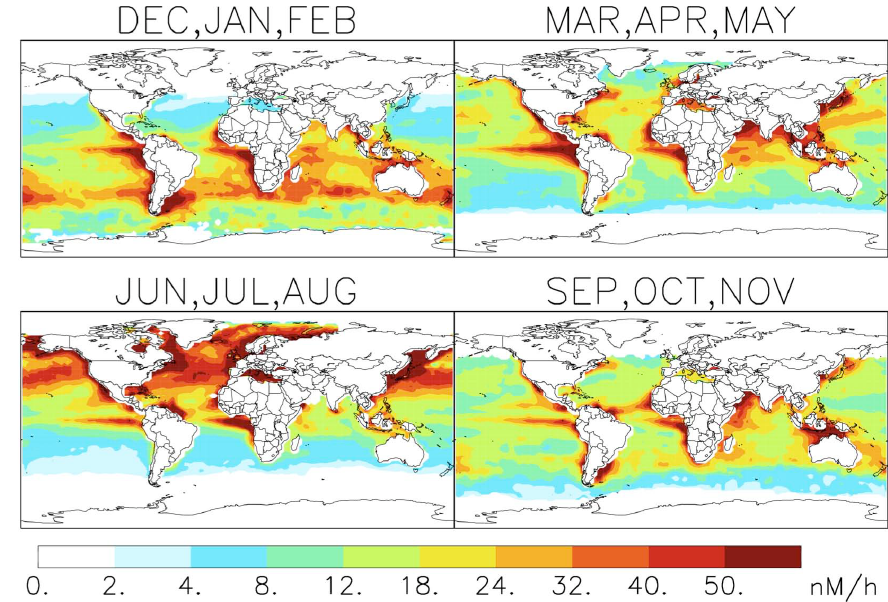
Fig. 5. Acetaldehyde photoproduction in the ocean mixed layer averaged by season. Photoproduction rates are estimated from colored dissolved organic matter absorption fields derived from SeaWiFS satellite observations as described in the text.